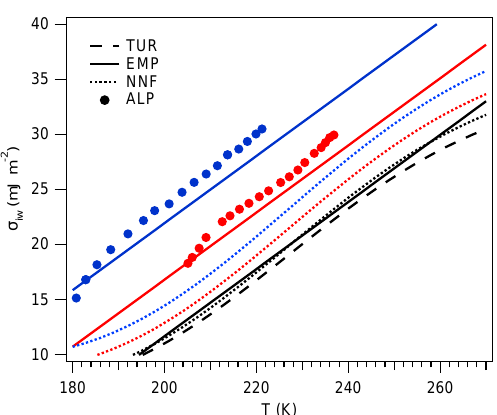
Fig. 2. Interfacial tension represented by different models: (TUR) Correlation of Turnbull (1950), Eq. (25). Figure 2. Interfacial tension represented by different models: TUR: (EMP) Empirical correlation derived from fitting CNT to the K00 parameterization (Koop and Zobrist, 2009; correlation of Turnbull (1950), Eq. (25). EMP: empirical correla- Koopetal.,2000),Eq.(29). (NNF)Physically-basedexpressionderivedfromtheNNFmodel,Eq.(27). (ALP) tion derived from fitting CNT to the K00 parameterization (Koop DatareproducedfromtheworkofAlpertetal.(2011). Black,redandbluelinescorrespondto a w equalto 1 : 0 , and Zobrist, 2009; Koop et al., 2000), Eq. (29). NNF: theoretical 0 : 9 and 0 : 8 ,respectively. expression derived from the NNF model, Eq. (27). ALP: data re- produced from the work of Alpert et al. (2011). Black, red and blue lines correspond to a w equal to 1.0, 0.9 and 0.8,